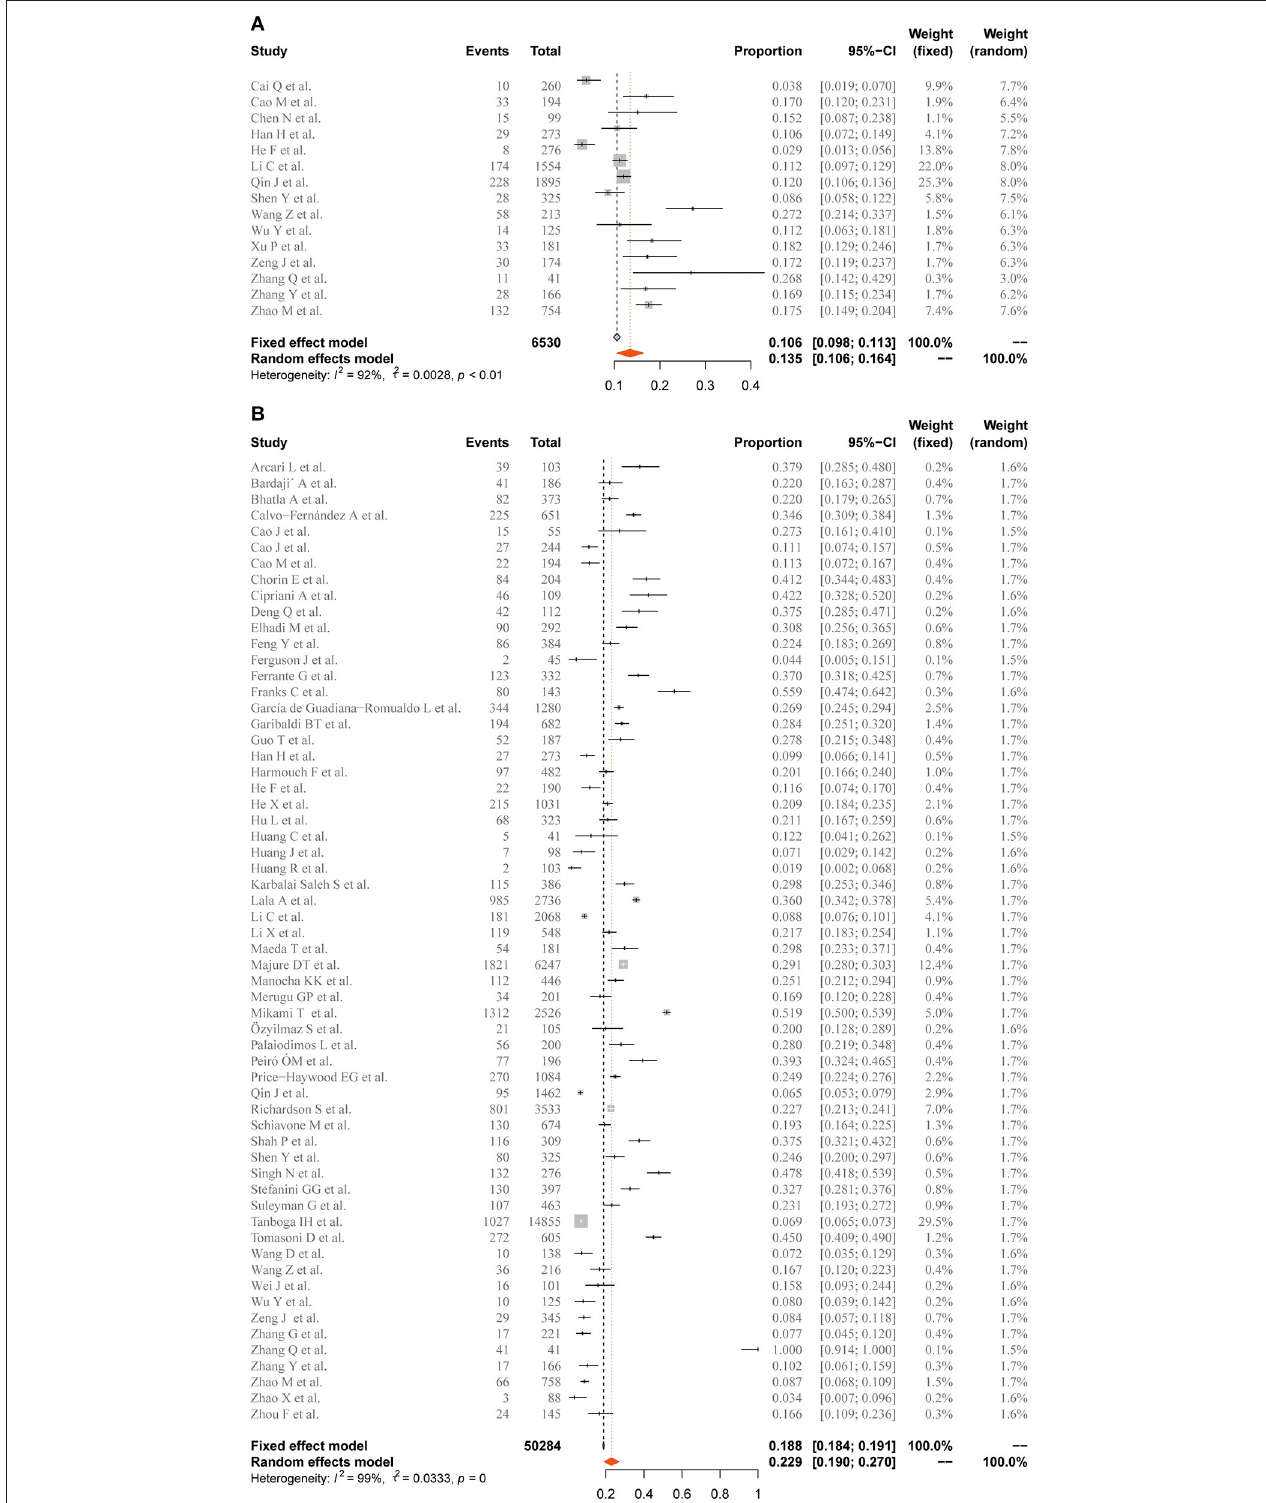
FIGURE 2 | Forest plot for the pooled prevalence of elevated (A) Mb and (B) cTnI in general population. Mb, myoglobin; cTnI, cardiac troponin I. Proportions are presented with fixed-effects when I 2 ≤ 50% and random-effects otherwise.